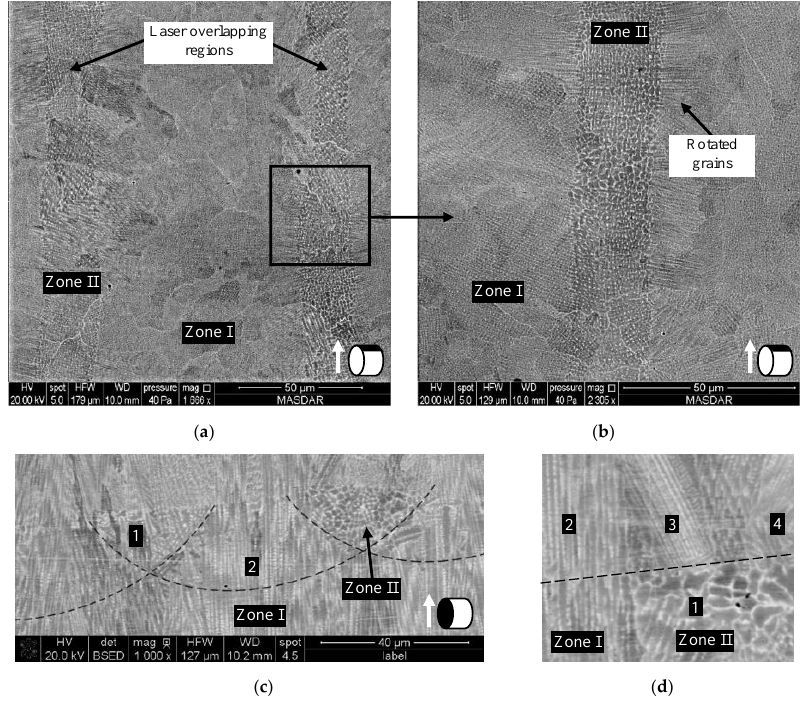
Figure 10. ( a ) SEM micrographs of the overlapping laser tracks microstructure in the x-y plane, with respect to the building direction z -axis (indicated with an arrow in the right low corner); ( b ) magnified image of one laser overlapping region; ( c , d ) cross section of laser overlapping region.